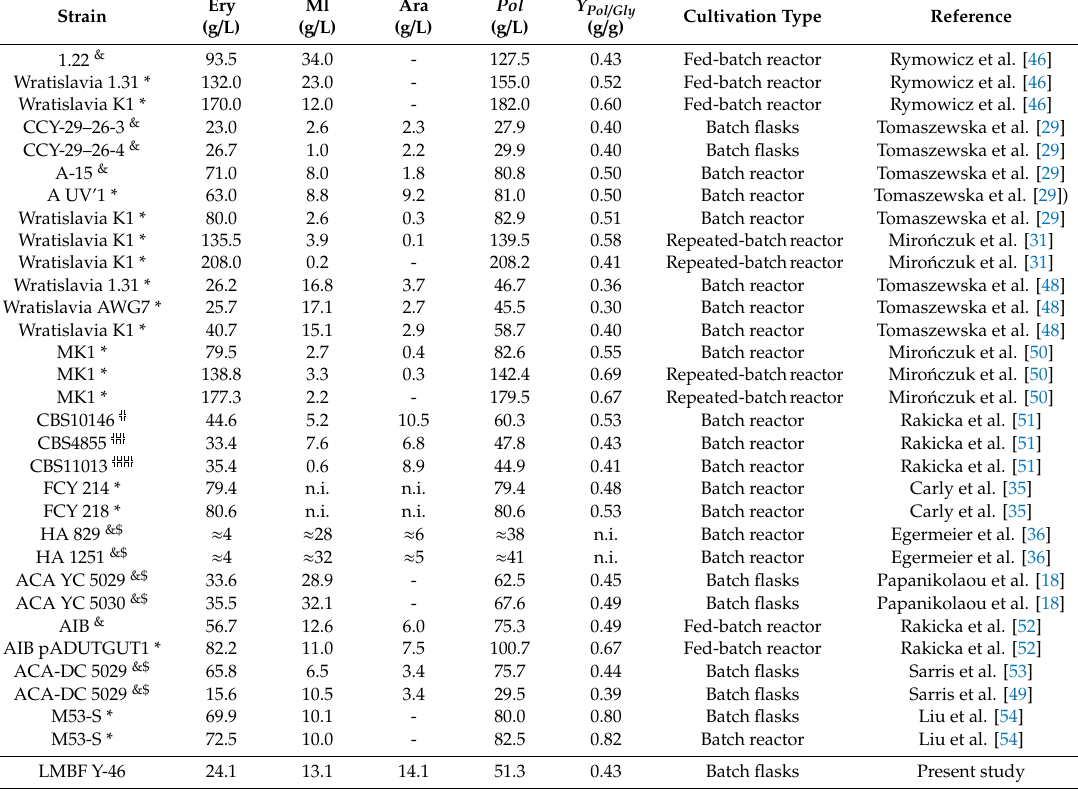
Table 2. Metrics of production of polyols by several yeasts belonging to Yarrowia and Candida clades during growth on glycerol in several fermentation modes. Comparison with the current study.